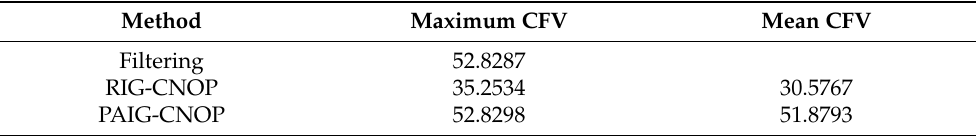
Figure 2. The distribution of the CFVs corresponding to the initial guesses generated by the different methods at point O , the prediction times T = 150. Table 1. Statistical analysis of the CFVs corresponding to the initial guesses generated by the different methods at point O , T =